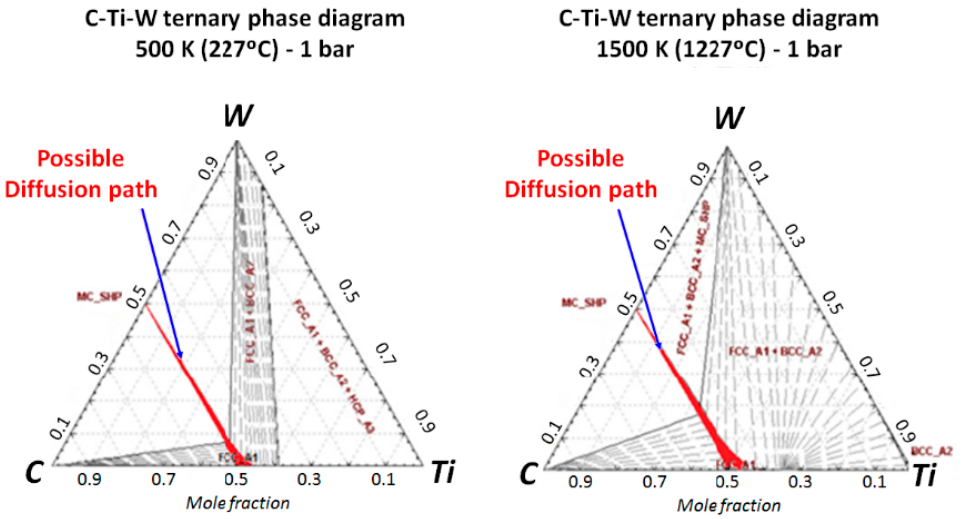
Figure 18. C-Ti-W ternary phase diagram at 627 °C (900 K) and 1227 °C (1500 K)